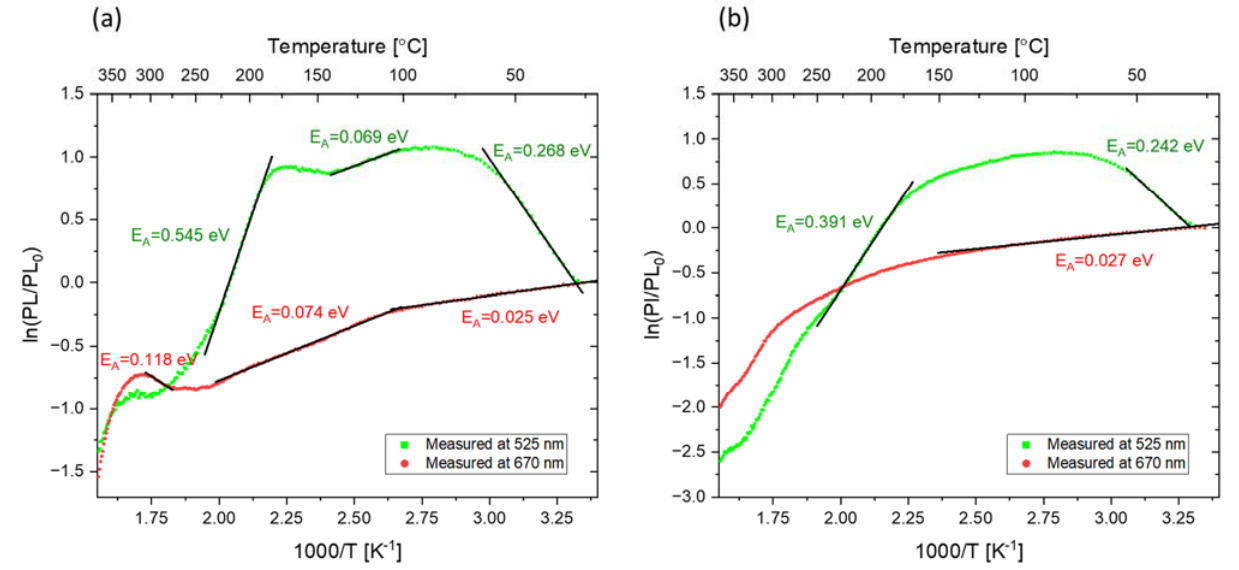
Figure 16. Arrhenius analysis of the changes in PL intensity with respect to the values at room temperature measured while heating the sample (the sample submitted to Method 2). Measured for: ( a ) the sample irradiated with 8 kGy of beta radiation from the Sr-90/Y-90 source and ( b ) the sample irradiated with alpha particles from the Am-241 source (fluence 10 12 cm − 2 ). All data are normalized to the respective values measured at RT.